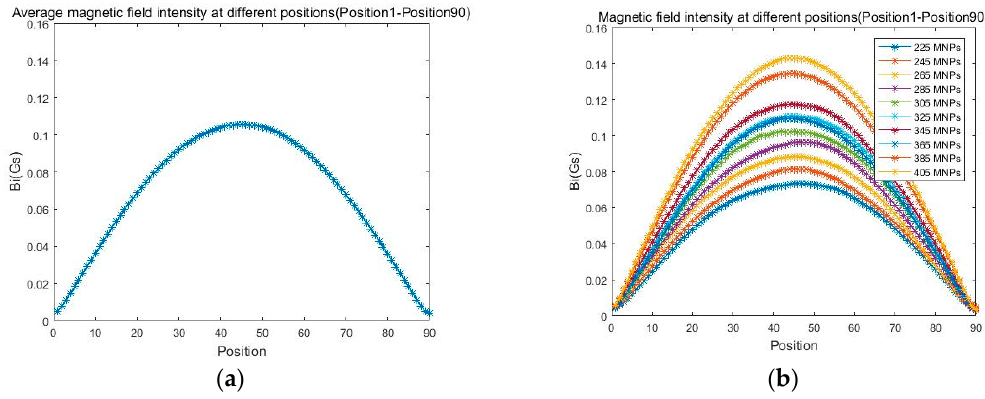
Figure 14. Response magnetic field intensity at different positions (Position1–Position90): ( a ) the average response magnetic field intensity at Position1–Position90 and ( b ) the response magnetic field intensity at Position1–Position90 with different number of MNPs.